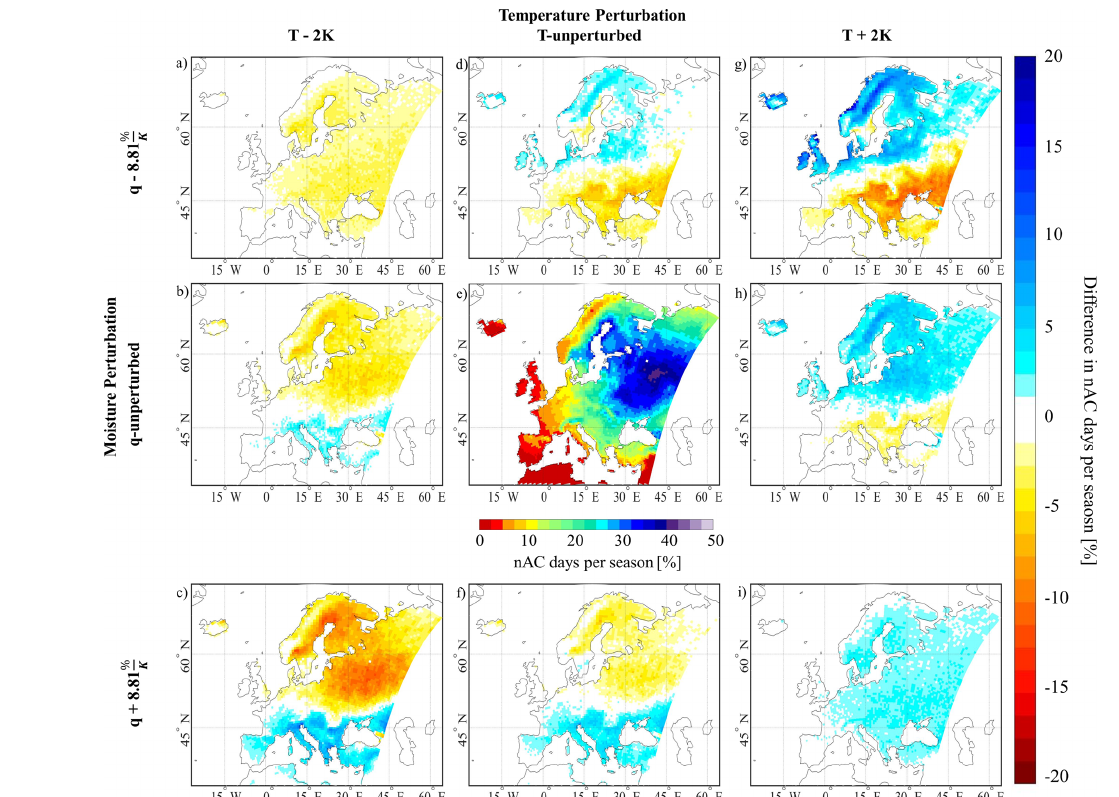
Figure 5. Difference in the seasonal share of non-atmospherically controlled (nAC) days [%] from CTRL for each modification case of the core set. The center image is the CTRL case modified after Jach et al. (2020) (their Fig. 4g). The columns denote the temperature change and the rows the relative change in